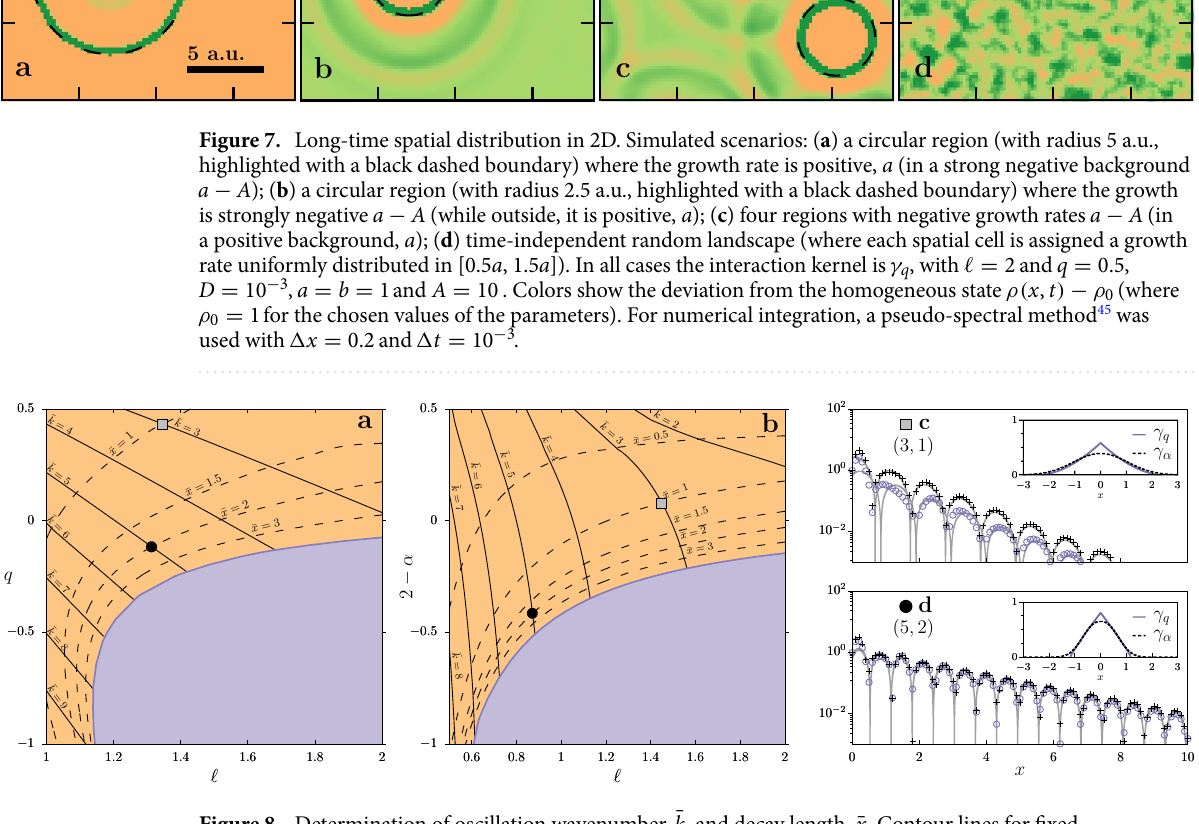
x . Contour lines for fixed Figure 8. Determination of oscillation wavenumber, ¯ k , and decay length, ¯ wavenumber (solid lines) and decay lengths (dashed lines). Colors for different oscillatory regimes are applied to the background as in previous figures. We considered the interaction kernel γ q , given by Eq. (4), in ( a ) and 3 and a 10 1 . The highlighted points γ α b N − 1 α e −| x /ℓ | α in ( b ). The remaining parameters are D − = = = ≡ ( 3, 1 ) (gray square) and ( ( 5, 2 ) (black circle). ( c ), ( d ) Oscillations produced by x ) k , x ) correspond to ( ¯ k , ¯ ¯ = ¯ = the kernels shown in the respective insets (case γ q in purple circles and γ α in black crosses). For both panels, the inset shows the kernels γ q (solid purple) and γ α (dashed black) obtained from the oscillation’s parameters ( 1.345, 0.433 ) , (ℓ , 2 α) ( 1.450, 0.079 ) (gray squares), and (d) for the highlighted points: ( c ) (ℓ , q ) = − = 0.116 ) , (ℓ , 2 0.413 ) (black circles). The gray lines show a sinusoidal fit for (ℓ , q ) ( 1.313, α) ( 0.871, = − − = − each case, namely ρ H ( x